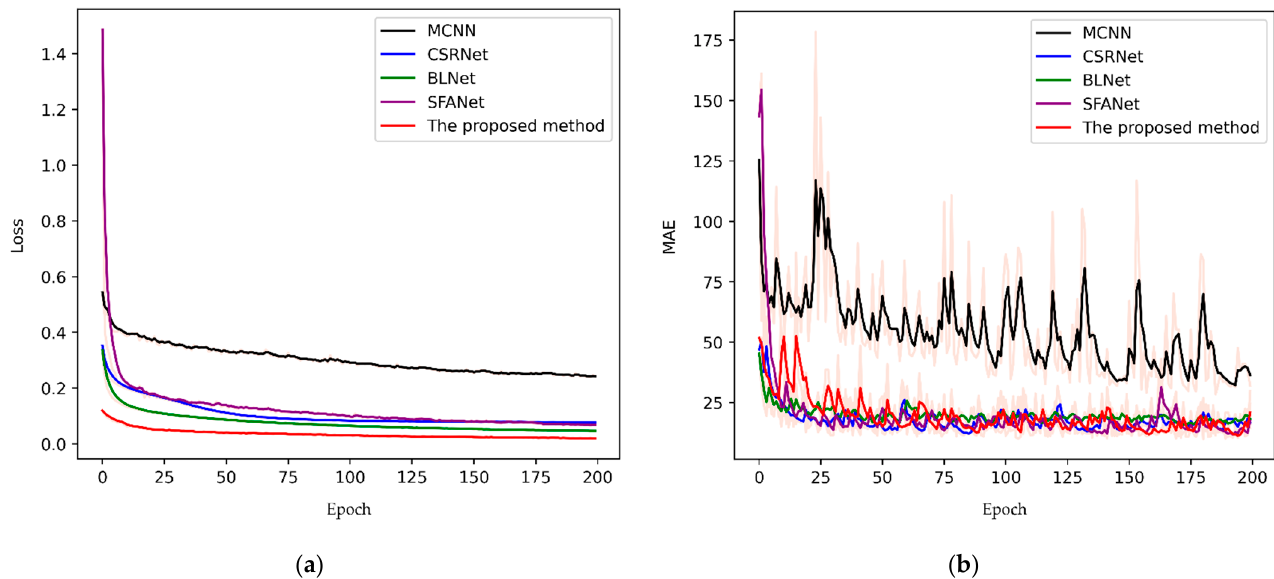
Figure 7. The results of DM-Nets training: ( a ) training loss curve; ( b ) MAE curve of validation. Table 2. The accuracy of different DM-Nets.